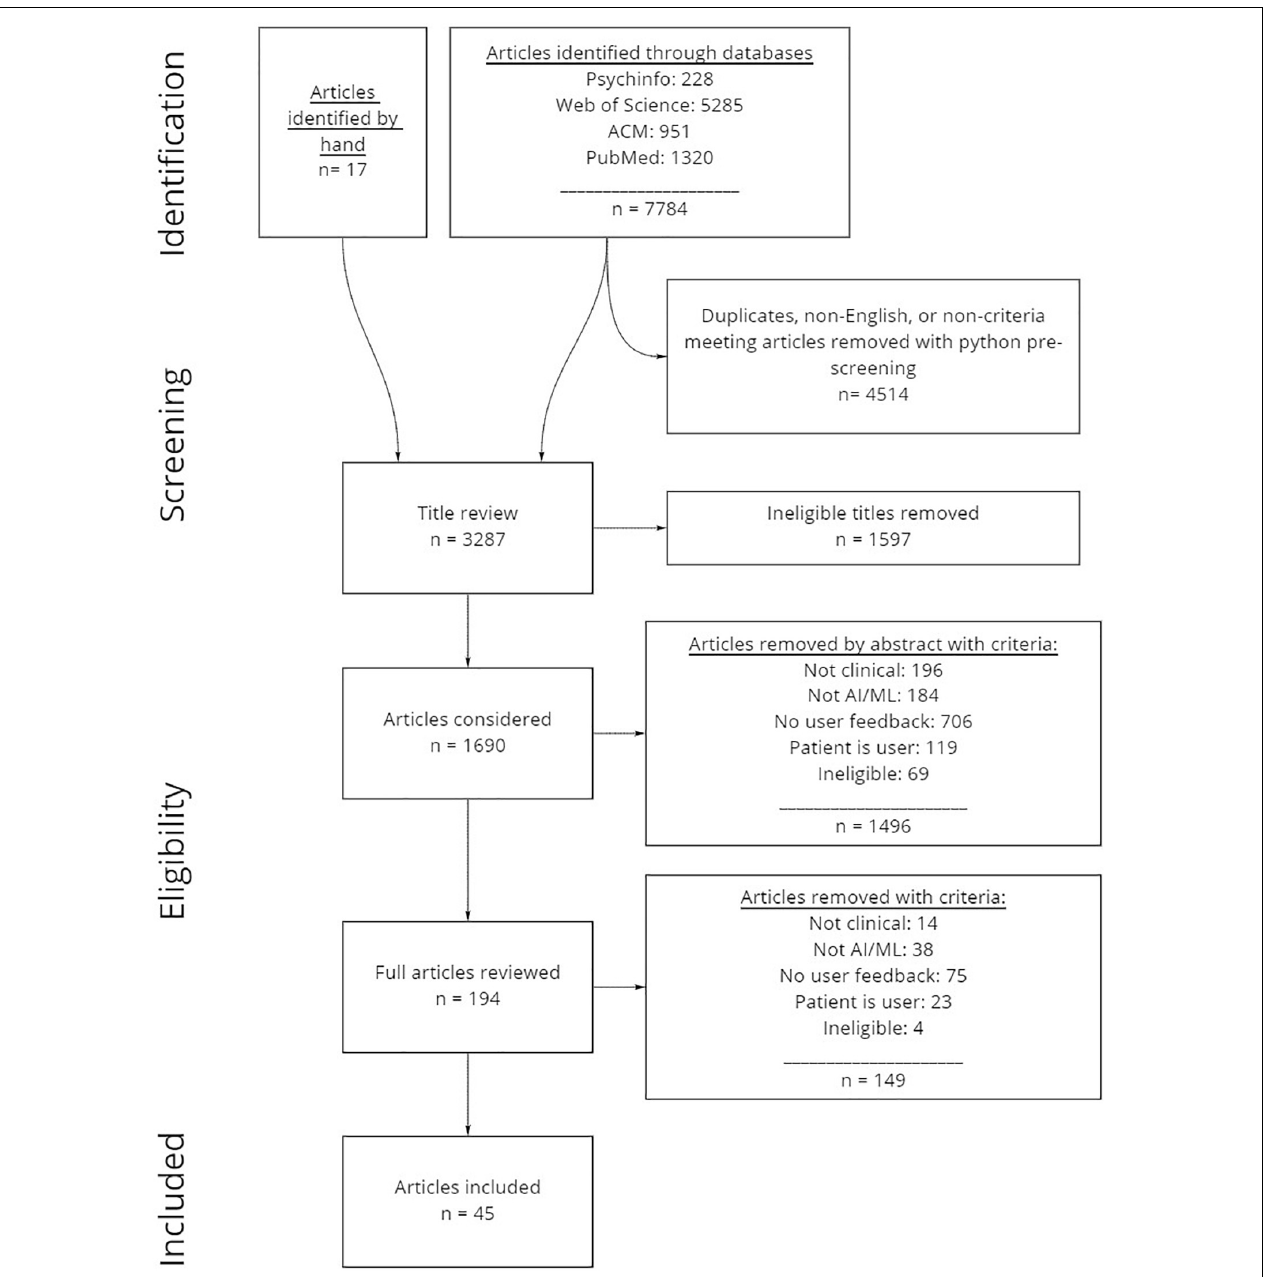
FIGURE 1 | Systematic review process and numbers of articles included and excluded. Articles were first identified through online databases, then pre-processed using python scripts. Next, all articles were manually reviewed by title and abstract prior to reviewing full articles to evaluate which articles were